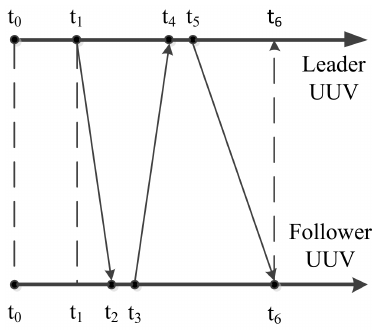
Figure 5. Time axes of the leader UUV and follower